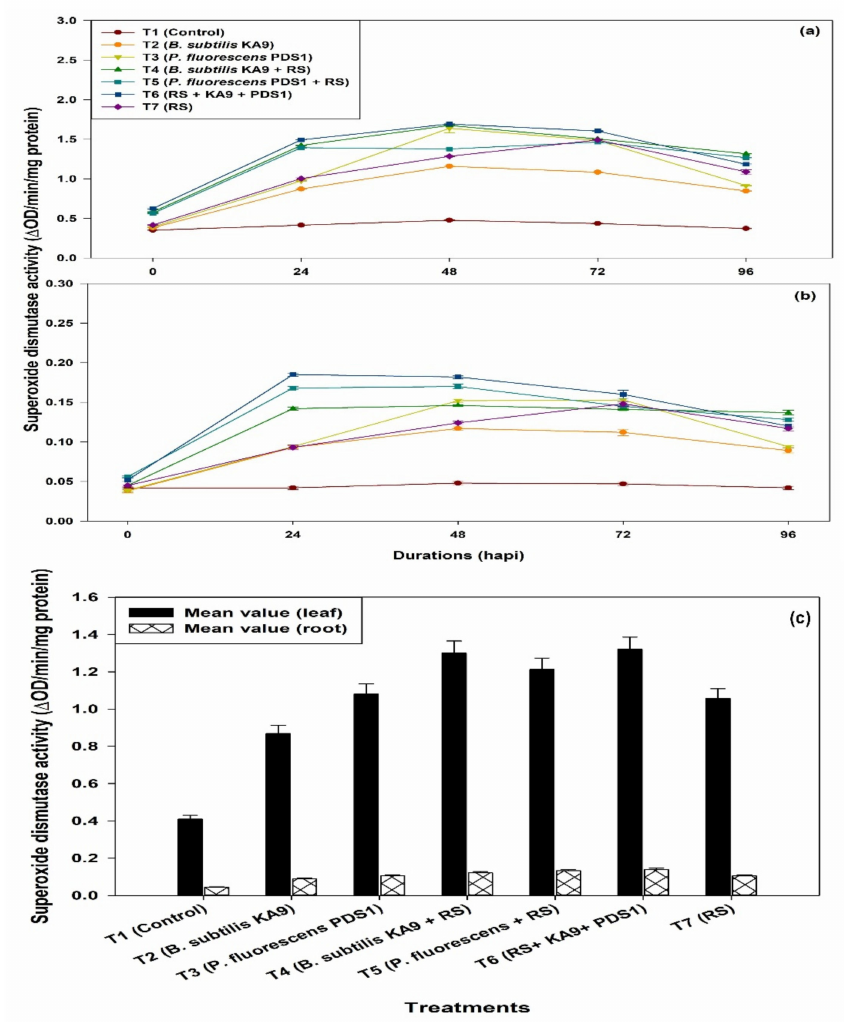
Figure 12. ( a ) The effect of biocontrol agents on the induction of superoxide dismutase activities in leaves of chilli crop against R. solanacearum in glasshouse conditions; observations were recorded after 30 days of sowing. ( b ) The effect of biocontrol agents on the induction of superoxide dismutase (SOD) activity in roots of chilli crop against R. solanacearum in glasshouse conditions; observations were recorded after 30 days of sowing. The results are expressed as average of three replications and error bars indicate standard deviation of the means. ( c ) Mean value comparison of the induction of superoxide dismutase activities in between chilli leaves and root tissue against R. solanacearum in glasshouse condition after 30 days of sowing. The results are expressed as average of three replications and error bars indicate standard deviation of the